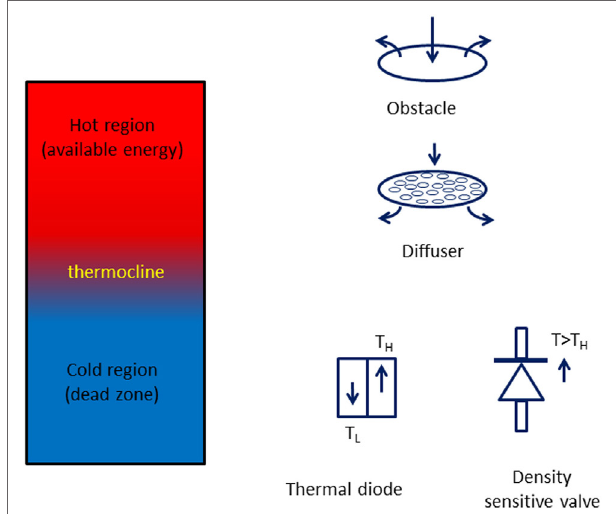
FigURe 4 | Thermal stratification phenomenon and its enhancement by inlet obstacles, diffusers, valves, and thermal